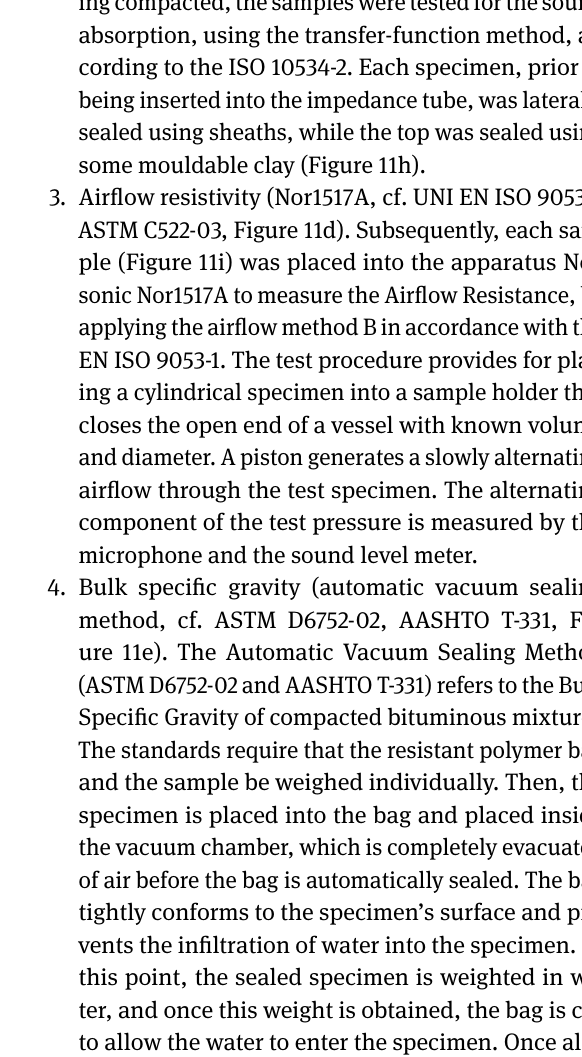
Figure 10: Top surface of samples